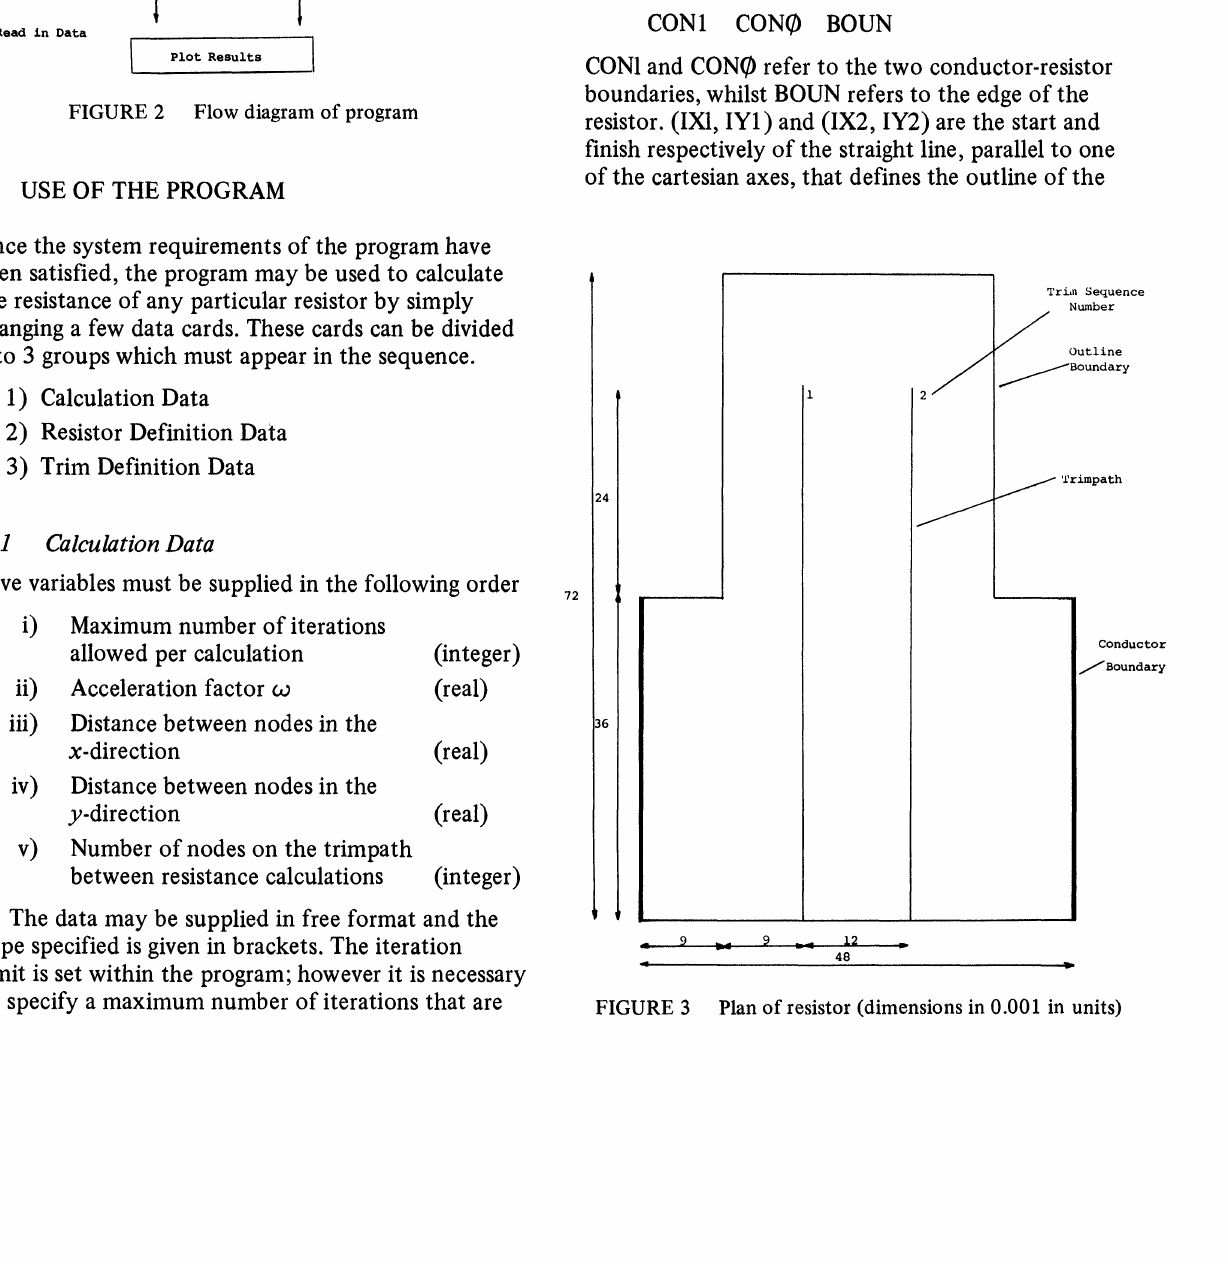
Plan of resistor (dimensions in 0.001 in